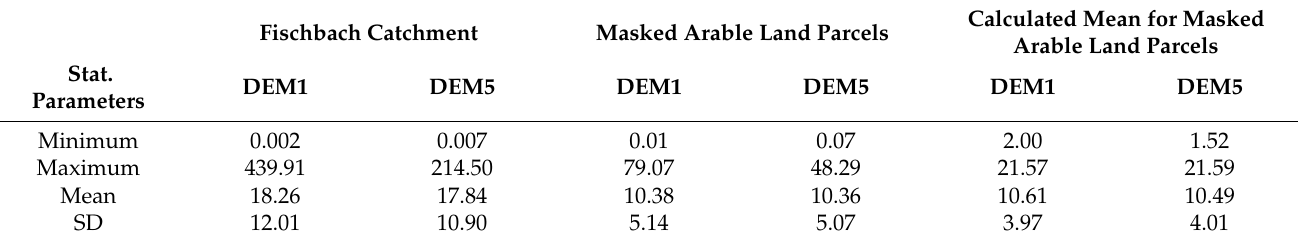
Table 3. Statistical parameters of slope (%) for DEM1 and DEM5; data source: [30,40]. Fischbach Catchment